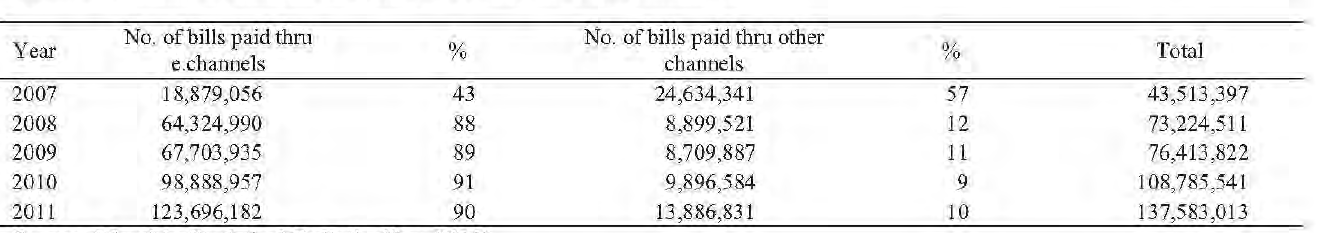
Table 1: Volume of bills paid through electronic and other channels Year